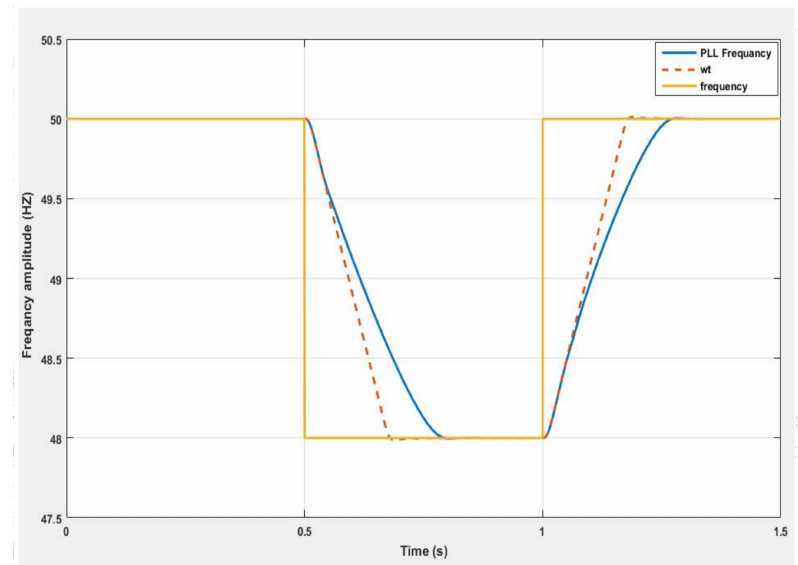
Figure 6. Frequency variation measurements between 48 and 50